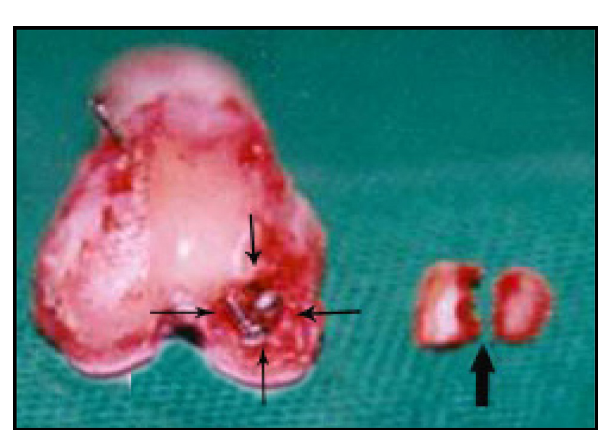
FIGURE 7 - Metallic synthesis with fixation flaw, presenting free body. (cid:7) = bed osteochondral with metallic pins, (cid:207) = body free with longitudinal